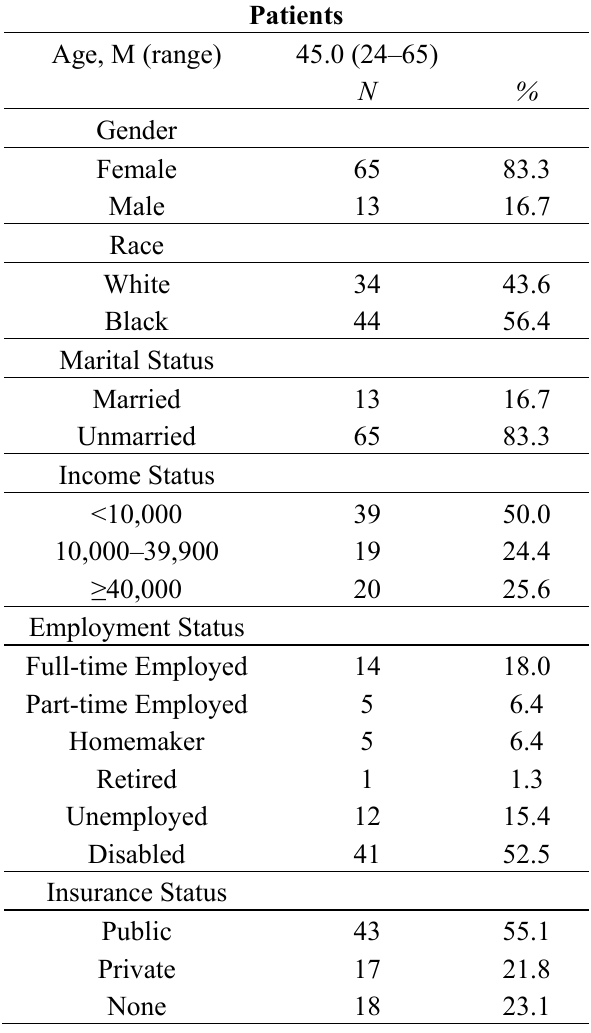
Table 1. Patient Demographic